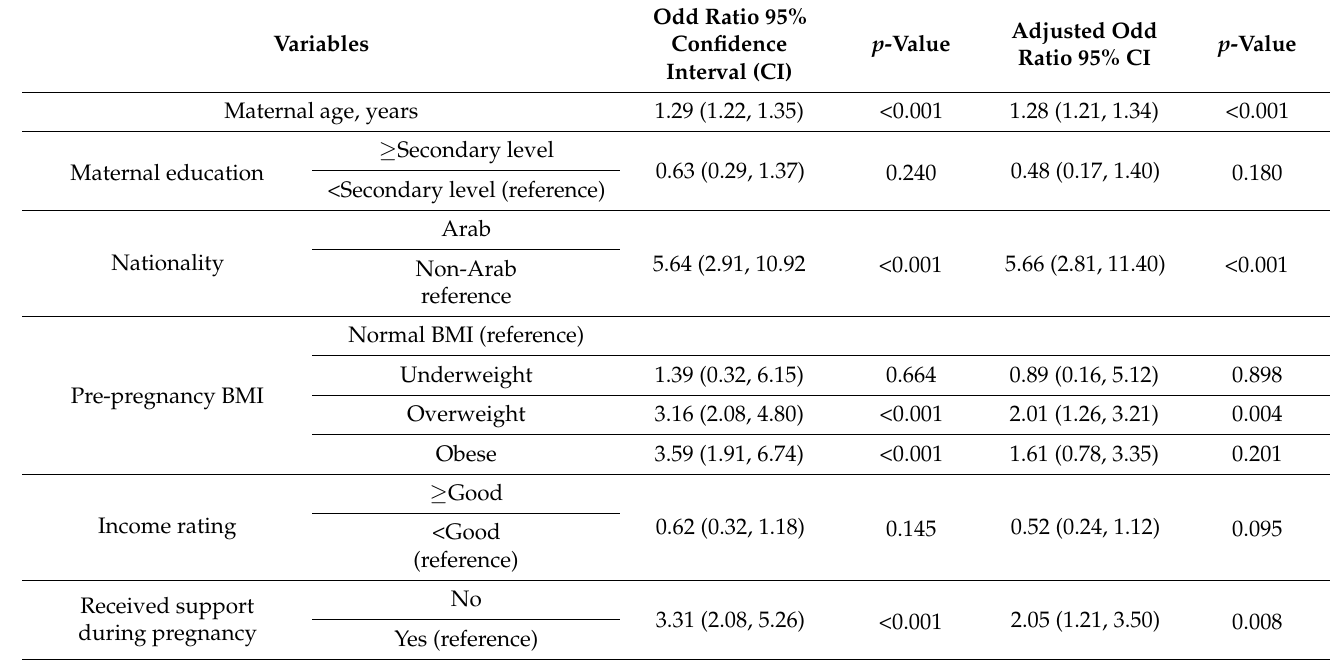
Table 2. Factors associated with grand multipara using logistic regression in Abu Dhabi, United Arab